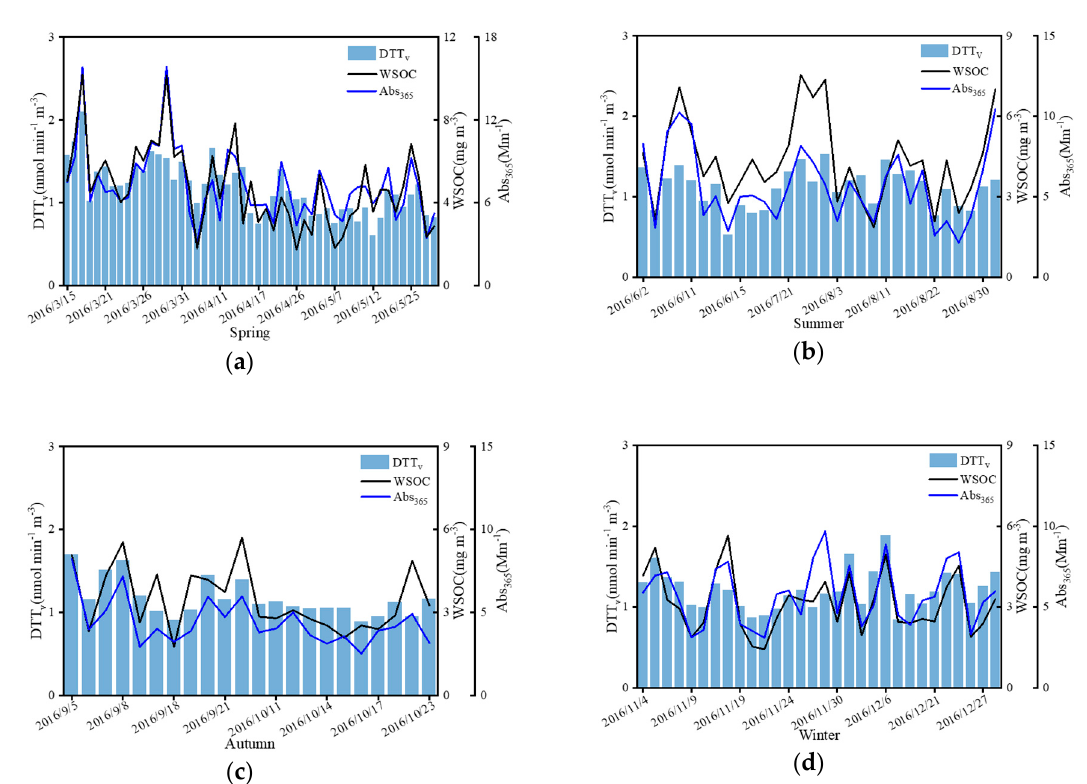
Figure 7. Concentration of WSOC, DTT v , and Abs 365 in spring ( a ), summer ( b ), autumn ( c ), and winter ( d